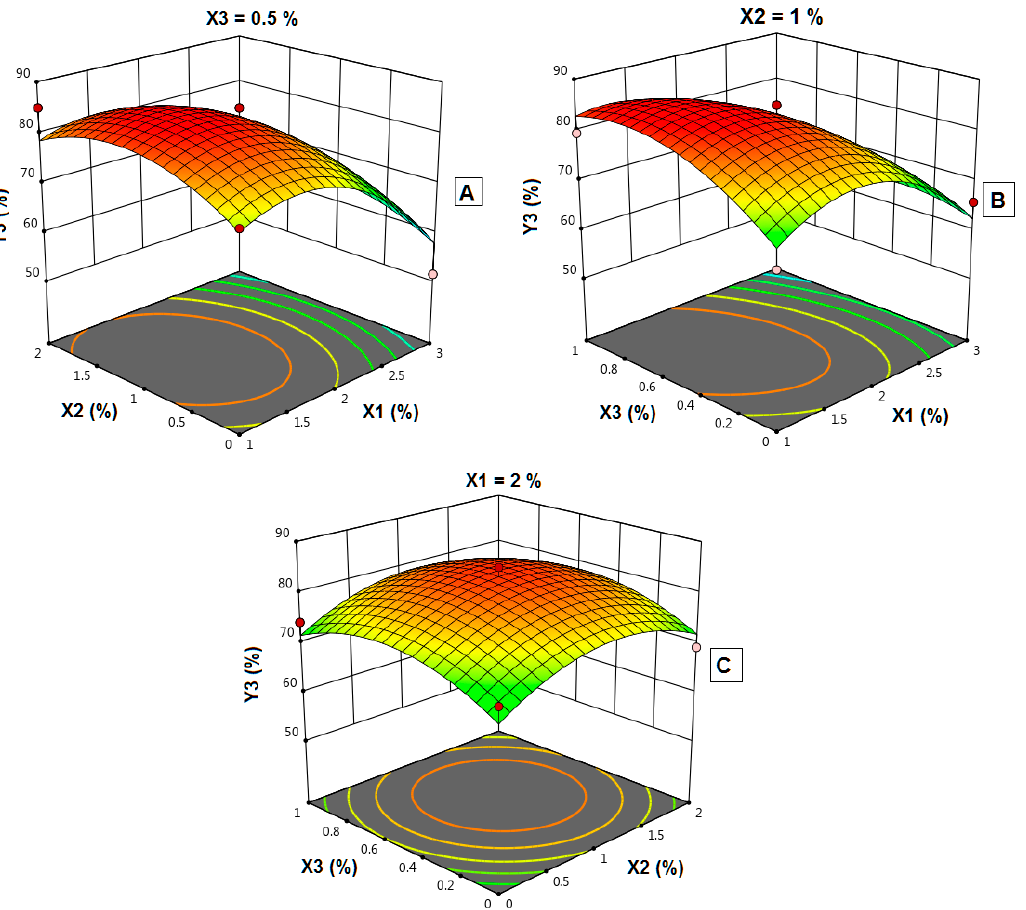
Figure 13. Effect of independent variables on dissolution efficiency (%) (Y 3 ). ( A ): Effect of polymer concentration (X 1 ) and plasticizer concentration (X 2 ) on Y 3 at 0.5% X 3 . ( B ): Effect of polymer concentration (X 1 ) and disintegrant concentration (X 3 ) on Y 3 at 1% X 2 . ( C ): Effect of plasticizer concentration (X 2 ) and disintegrant concentration (X 3 ) on Y 3 at 2% X 1 .